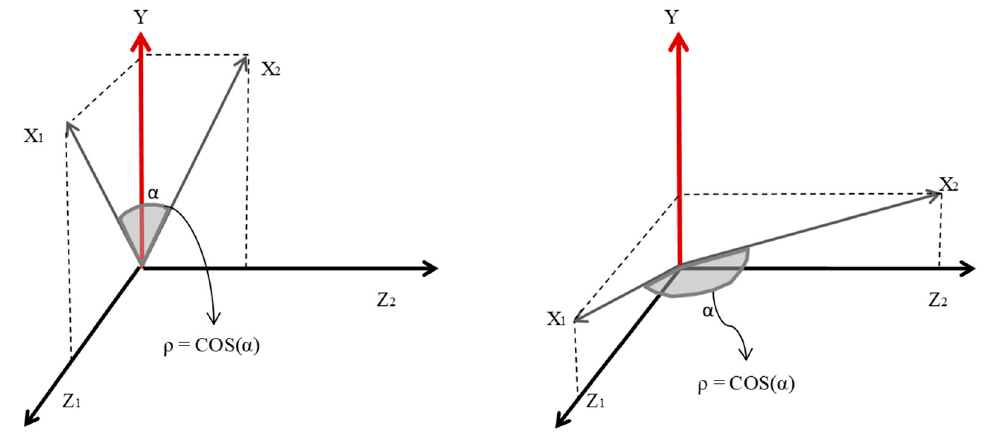
Figure 1. Graphical presentation of asset correlation.